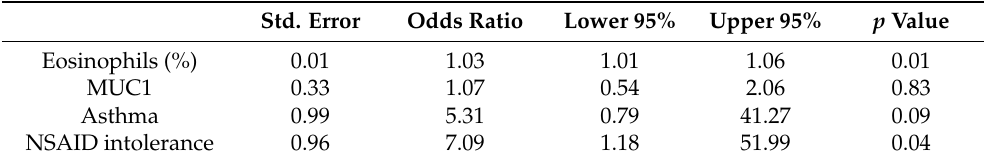
Table 4. Association between SNOT-22 and the parameters Eosinophil percentage, MUC1